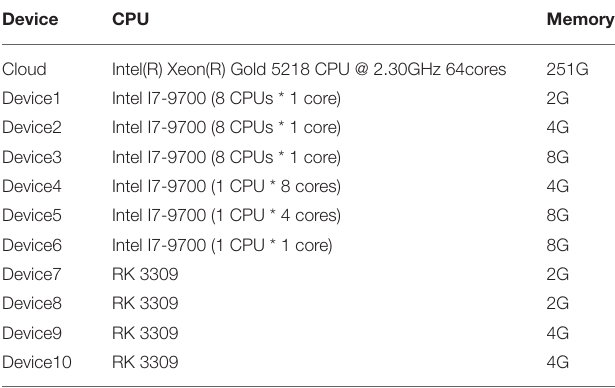
TABLE 1 | Detail of devices used in this